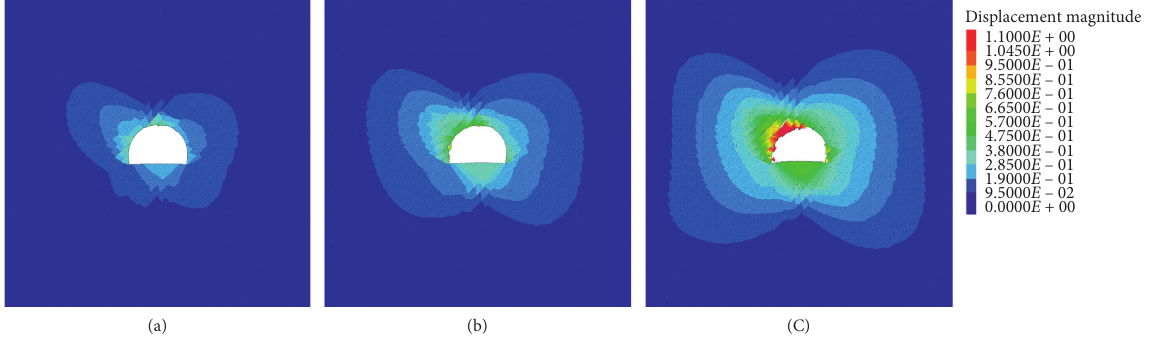
Figure 11: Displacement characteristics of the surrounding rock under different buried depths: (a) H � 250m, (b) H � 350m, and (c) H � 500m.